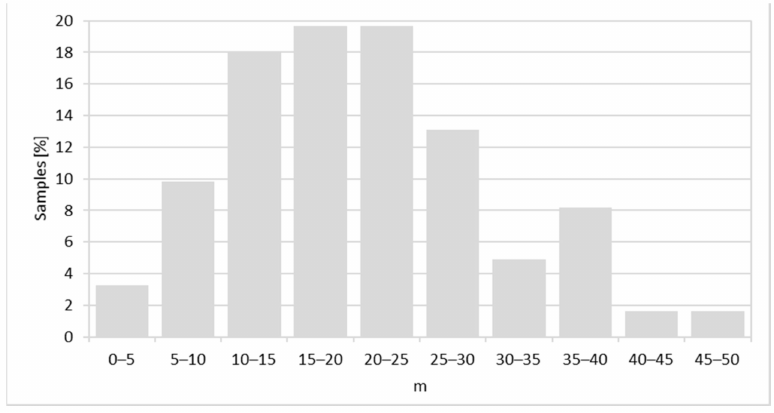
Figure 8. Distance in meters between planned and actual sampling